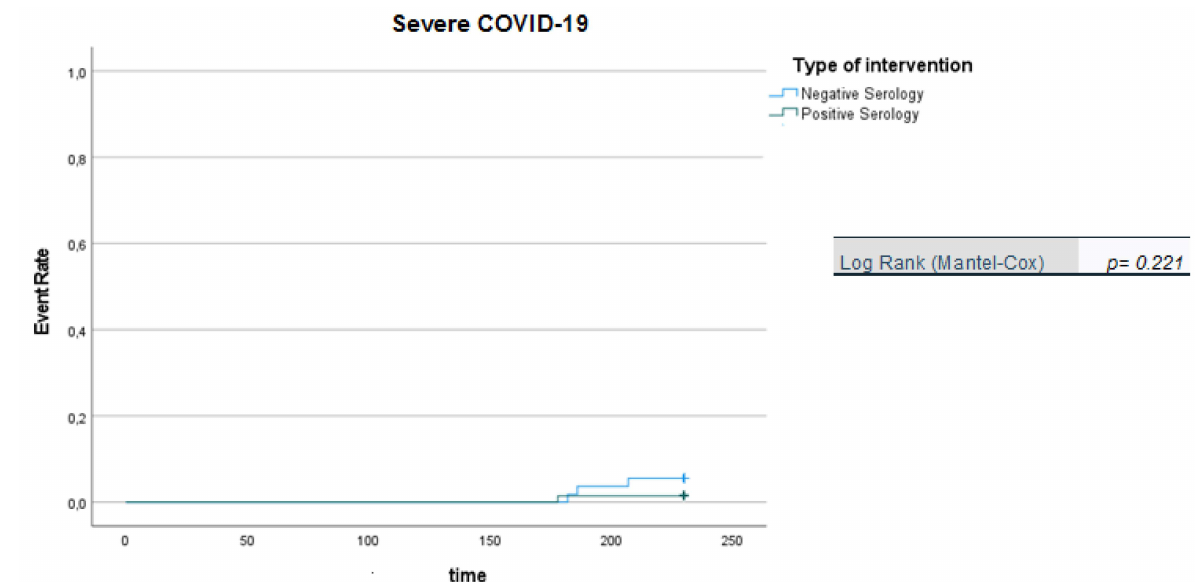
Figure 2. Kaplan-Meier curves: positive vs. negative serology in COVID-19 (in days).